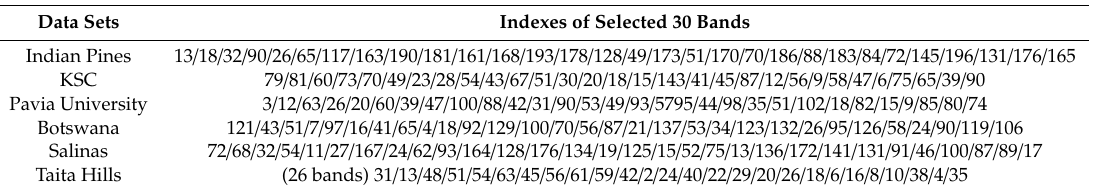
Table 1. Bands selected by band ranking via extended coe ffi cient of variation with dropping adjacent bands (BRECVD) on di ff erent data sets.